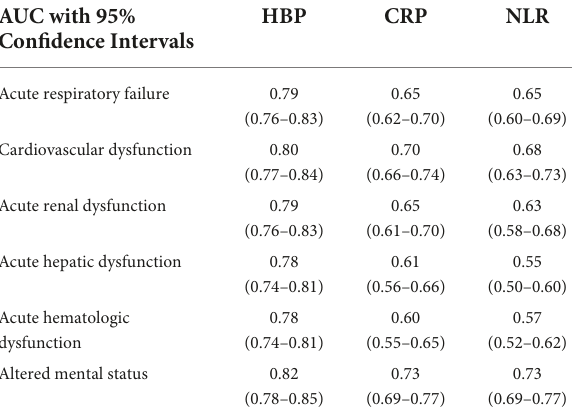
TABLE 2 Discrimination of HBP, CRP, and NLR on acute organ dysfunction.